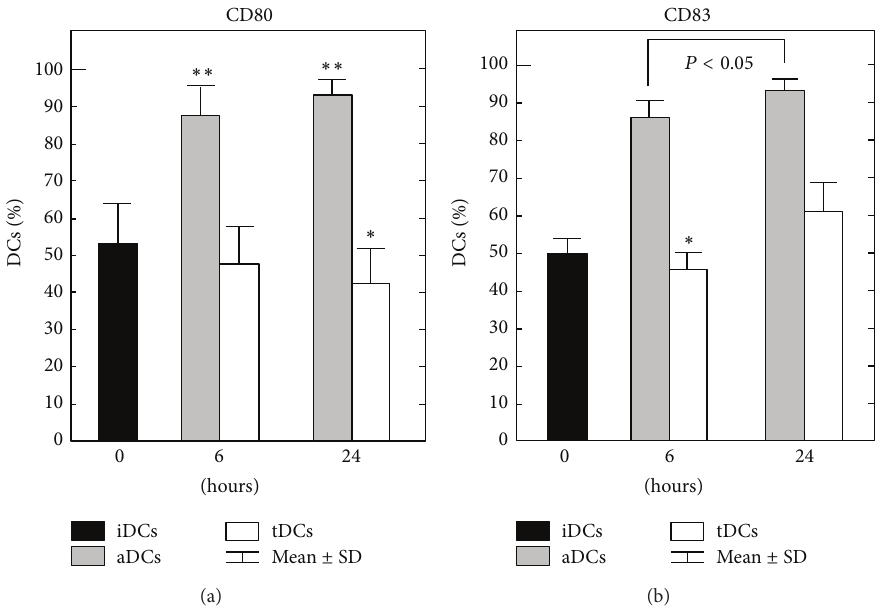
Figure 1: Expression of surface markers CD80, CD83 on DCs after maturation. Immature iDCs were cultured with GM-CSF (800 UI/mL) and IL-4 (500 UI/mL) for 6 days. On day 6 iDCs media were replaced with media containing LPS and IFN- 𝛾 (aDCs) or with media containing IL-10 and TGF- 𝛽 (tDCs) for the next 6 h or 24h of maturation. DCs were subsequently washed and the surface markers CD80, CD83, CD86, and HLA-DR were measured using flow cytometer. The results are expressed as mean ± SD of eight individual experiments. ∗ 𝑃 < 0.05 ; ∗∗ 𝑃 < 0.001 (significant difference to iDCs). Exact 𝑃 values are given in Section